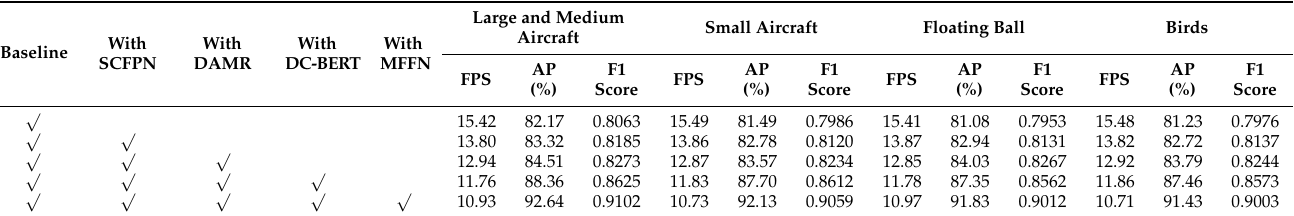
Table 2. The effectiveness of various designs in our infrared small-detection network.